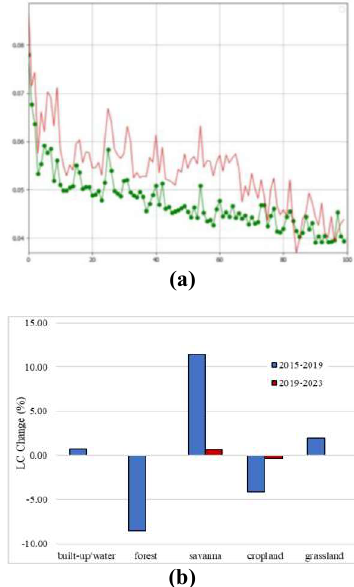
Figure 4 . Result of transition potential modelling in MOLUSCE: (a) Neural network learning curve, (b) LULC